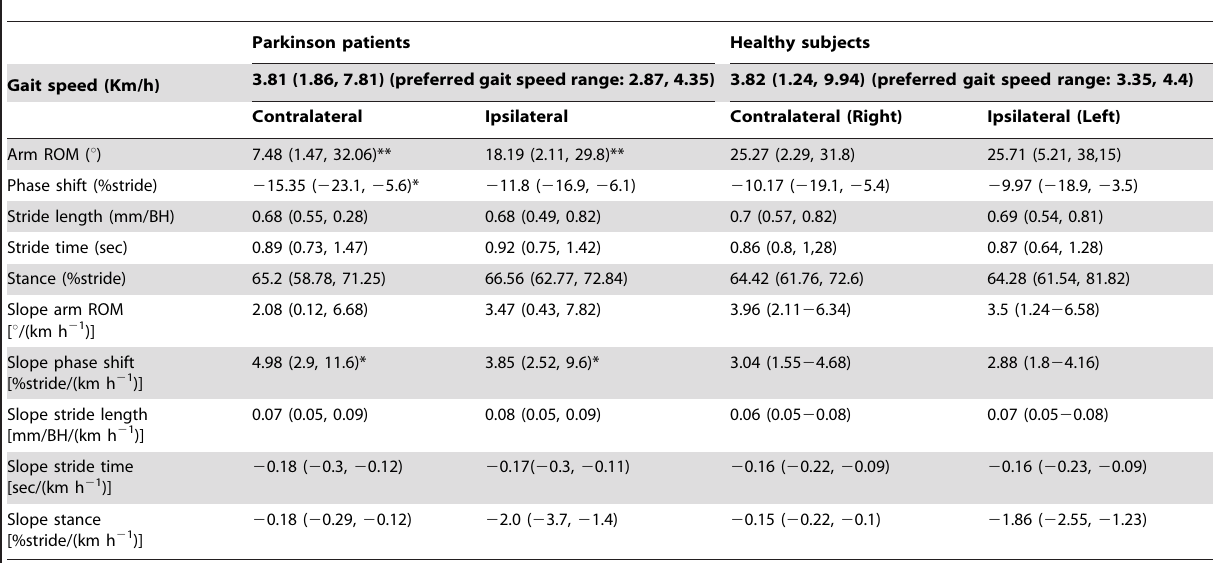
Table 1. Spatio-temporal parameters of the stride, arm ROM and phase shift of subjects with Parkinson disease and healthy